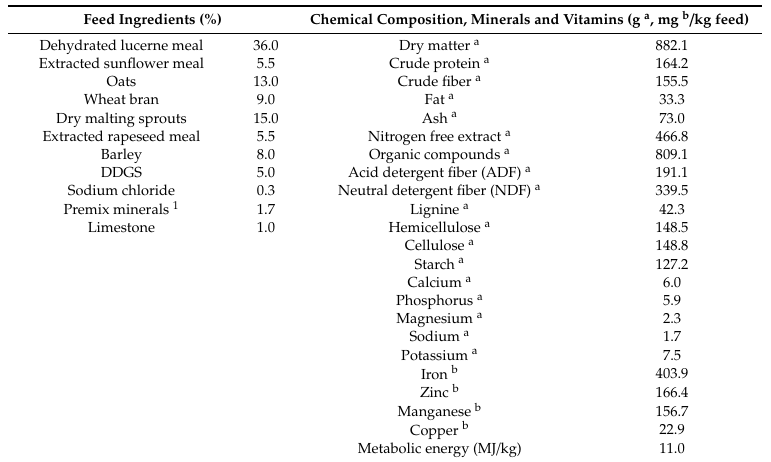
Table 1. Ingredients and chemical composition of granulated diet.